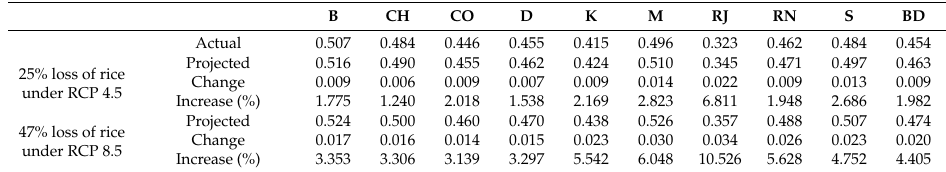
Table 17. Changes in poverty rates following a loss of rice yield due to RCPS. B CH CO